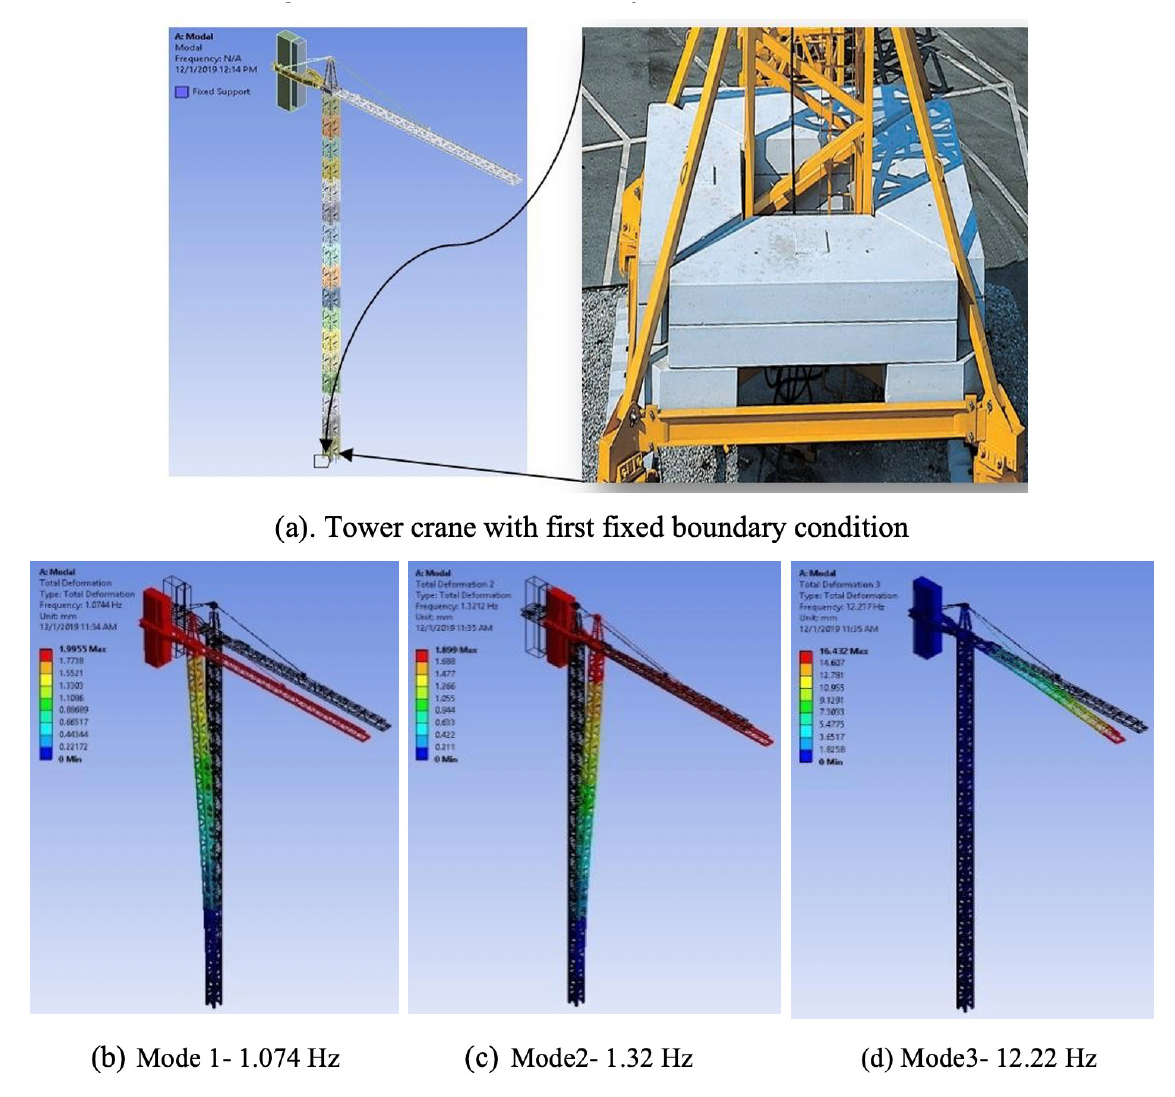
Figure 8. Modal parameter of tower crane with first boundary condition